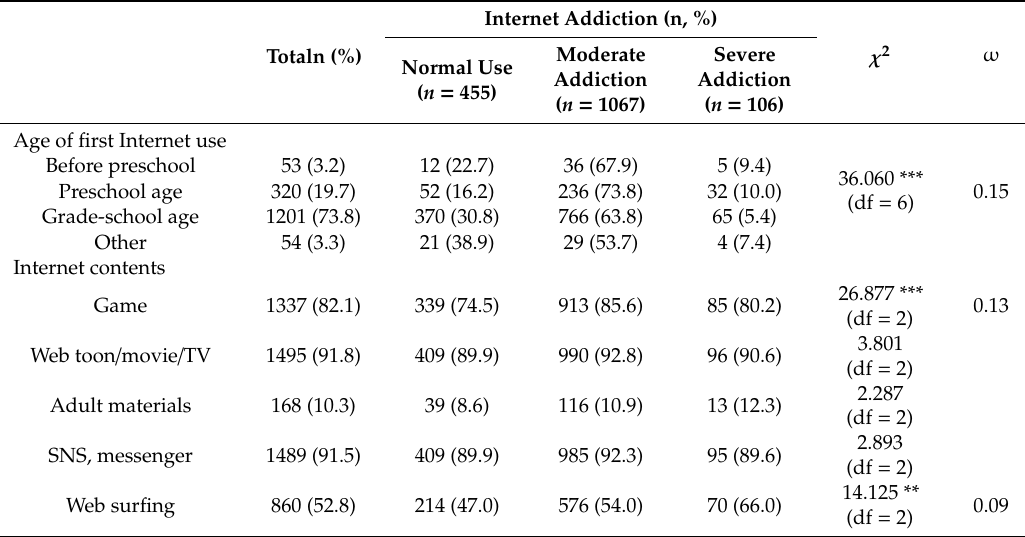
Table 2. Internet use behavior ( N =